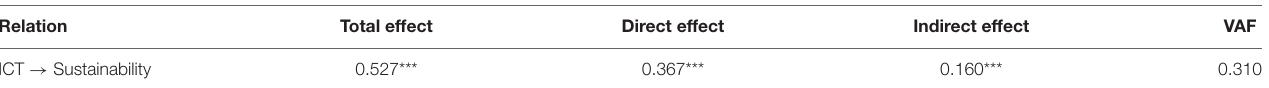
TABLE 7 | Summary of mediating effect